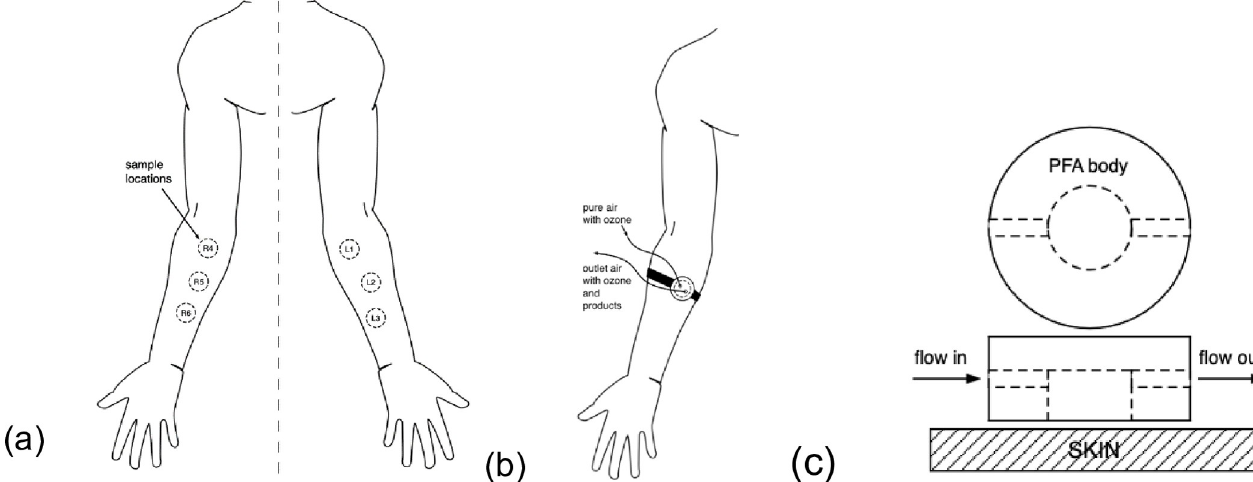
Fig 1. Diagrams of sampling locations and flow cell. a) Sample locations on forearm; b) attached flow cell; c) flow cell plan view and cross-section (gauze not shown).